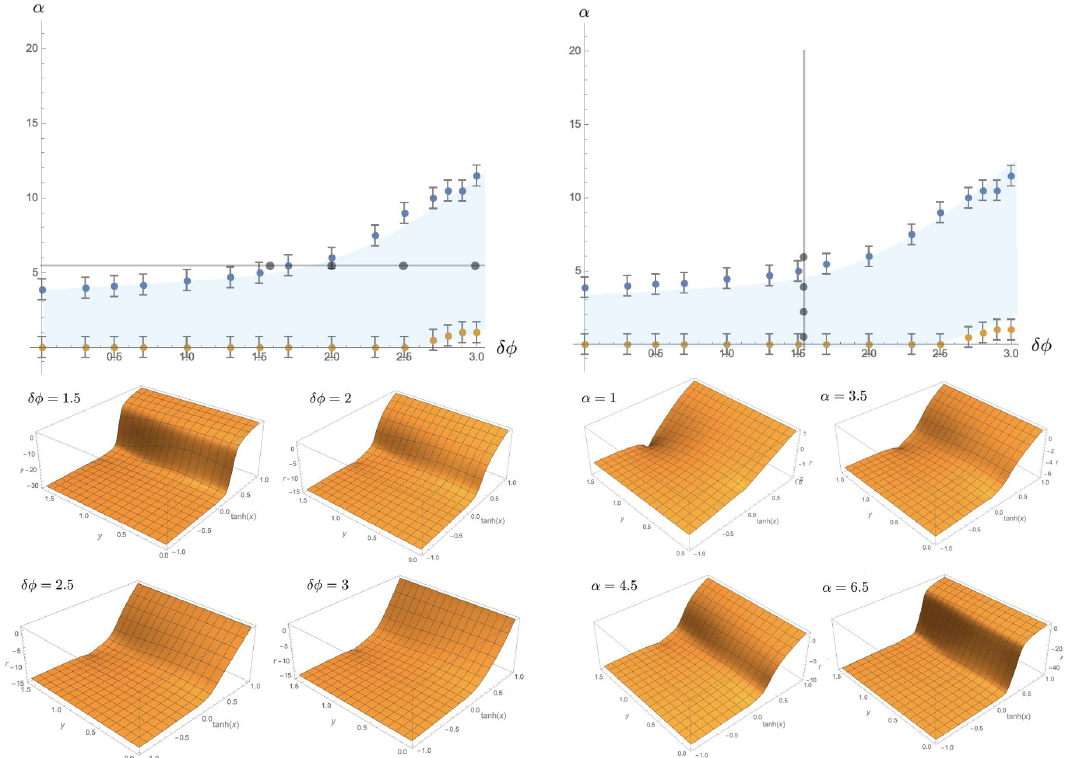
Figure 8 . An illustration of the evolution of the minimal surface at zero temperature and non-zero dilaton variation. On the right, (a family of) backgrounds is fixed for a geometric ration α = 5 . 5 . In both cases, the surface is indicated by a dot at the location of its values ( δφ, α ) in the graph. On the left, one can see how, for a fixed dilaton variation δφ = 1 . 7 , the surface settles into the horizon for backgrounds that approach the critical geometric ratio. At zero temperature the surfaces are shift-invariant in the radial direction, so ∆ r is the meaningful quantity.